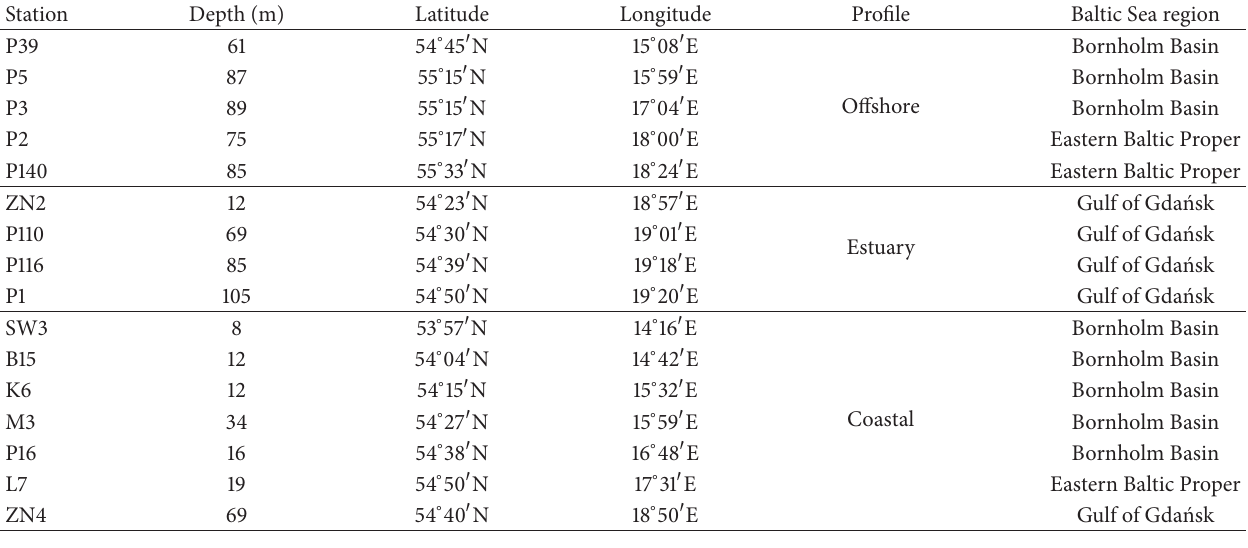
Table 1: Coordinates and total depth of the sampling stations.